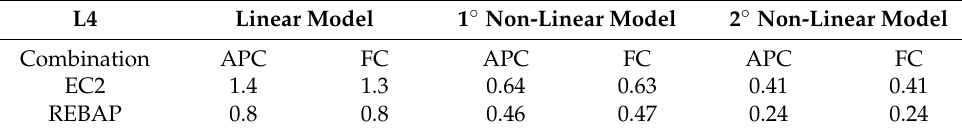
Table 13. Deformation ratios from LM, 1NLM and 2NLM for the third case of study of L3. L4